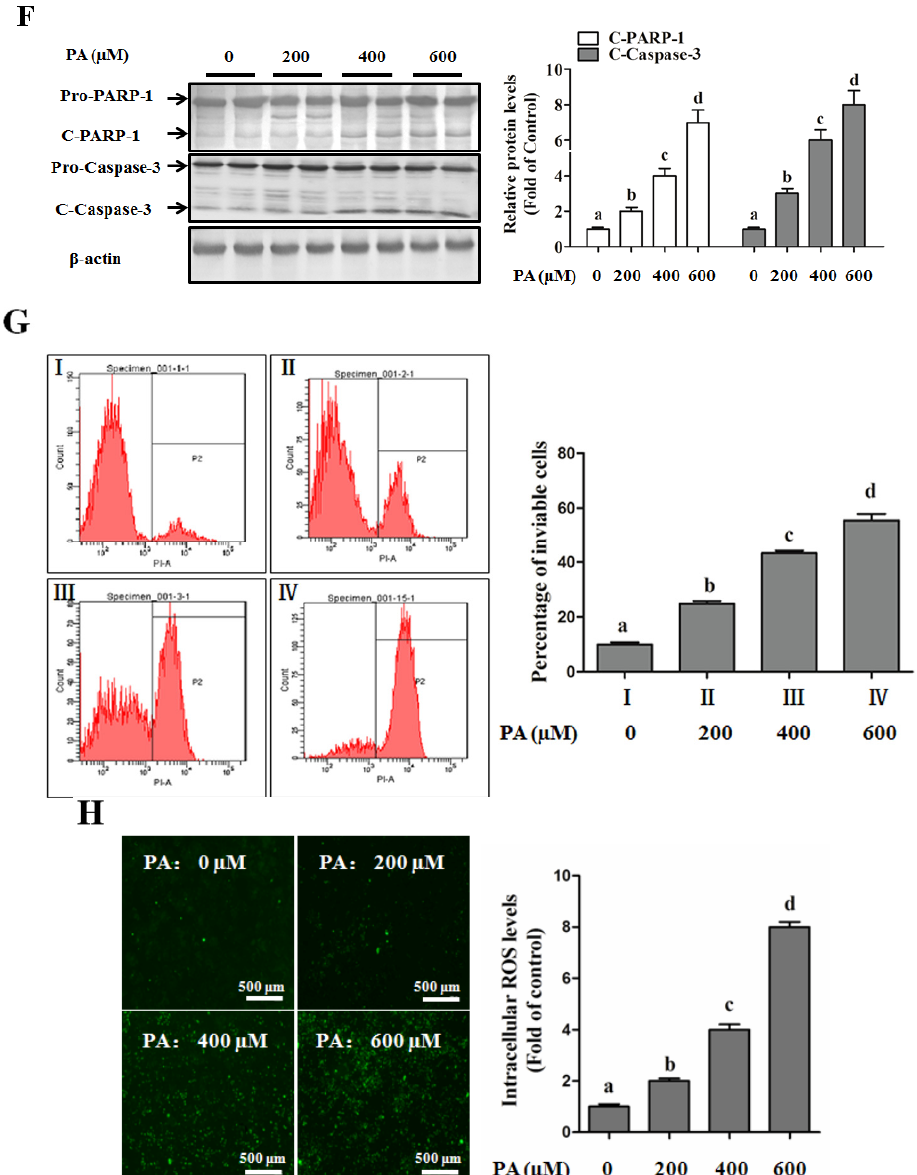
Figure 1. SFA ‐ induced hepatic lipotoxity in c57bl/6 mice and HepG2 cells. C57bl/6 mice were fed with a normal diet (ND) or high ‐ fat diet (HFD) for 8 weeks. Plasma ALT and hepatic TG contents were detected as described in the Materials and Methods. HepG2 cells were treated with palmitic acid (PA) with the indicated dosage for 12 h. ( A ) Plasma ALT ( n = 8); ( B ) liver TG ( n = 8); ( C ) LDH in the cultured medium was detected as described in the Methods; ( D ) Cell viability was detected by MTT test; ( E ) Nuclear morphology was detected by Hoechst staining using fluorescence microscopy (magnification × 100); ( F ) Total lysates of HepG2 cells were subjected to immunoblotting assay for Caspase ‐ 3 and PARP ‐ 1; ( G ) Cell death was dectected by propidium iodide staining with flow cytometry; ( H ) Intracellular ROS production was measured by DCFH ‐ DA stain using fluorescence microscopy (magnification × 100). Each in vitro test was performed at least 3 times. Bars with different characters differ significantly ( p < 0.05).